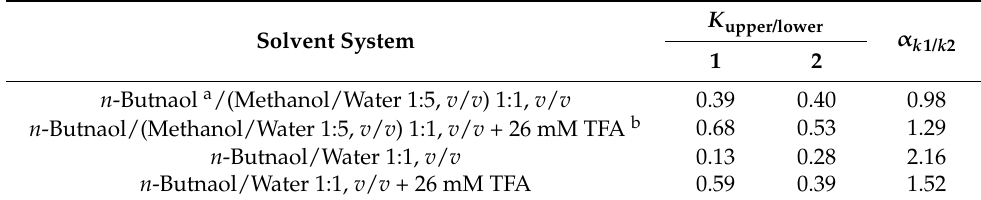
Figure 3. HPLC chromatograms of the separated or fractionated compounds from 70% methanol extract of M. volcanica by polarity-stepwise elution CCC. ( A ) HPLC chromatogram of the 70% methanol extract of M. volcanica ; ( B – J ) HPLC chromatograms of the separated or fractionated compounds by polarity-stepwise elution CCC. Moreover, the separated compounds are later identified as shikimic acid ( 2 ), gallic acid ( 3 ), protocatechuic acid ( 4 ), 4,4 (cid:48) -dihydroxy-3,3 (cid:48) -imino-di- benzoic acid ( 6 ), miquelianin ( 7 ), rutin ( 8 ), quercitrin ( 9 ), and quercetin ( 10 ). Table 3. Partition coefficients ( K upper/lower ) of compounds 1 and 2 , and the separation factors ( α ) between K 1 and K 2 at each solvent